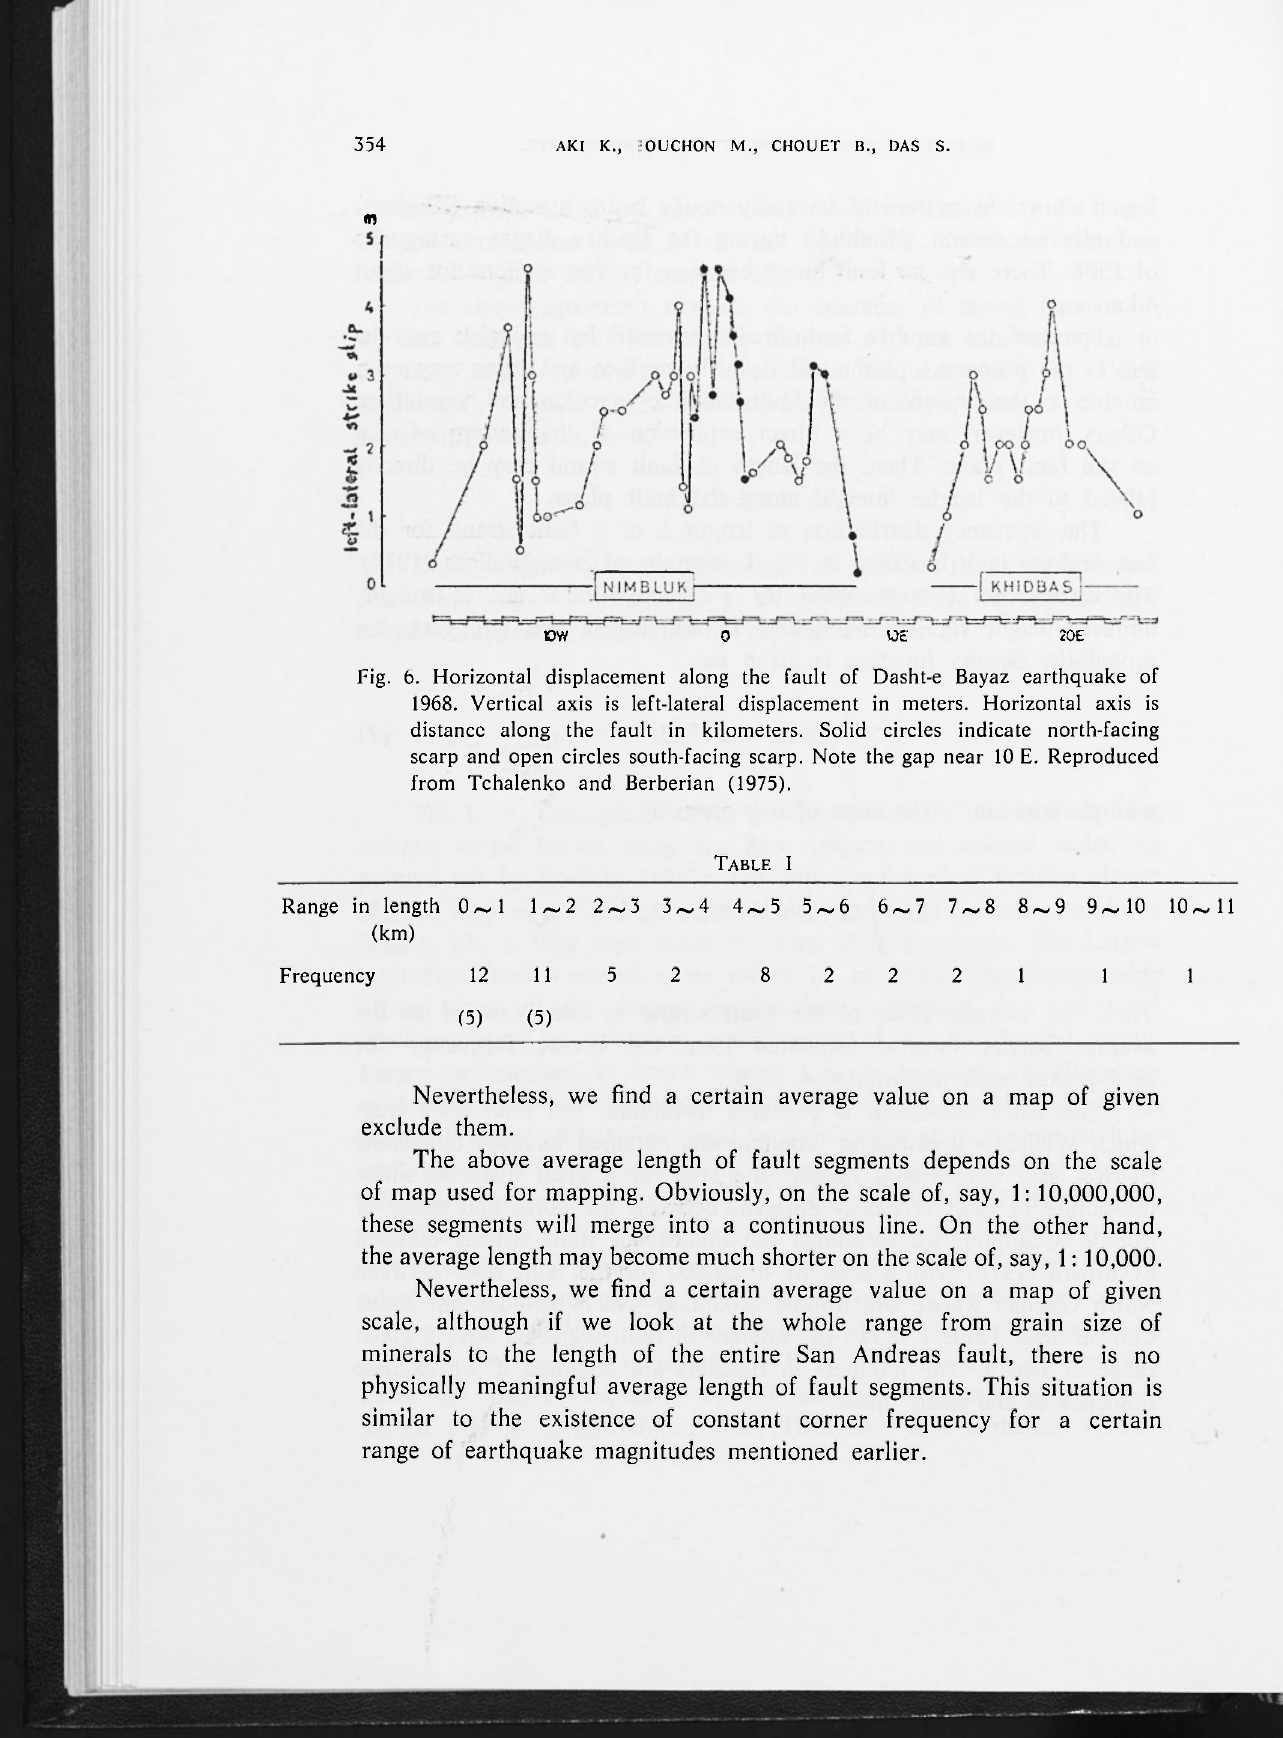
Fig. 6. Horizontal displacement along the fault of Dasht-e Bayaz earthquake of 1968. Vertical axis is left-lateral displacement in meters. Horizontal axis is distance along the fault in kilometers. Solid circles indicate north-facing scarp and open circles south-facing scarp. Note the gap near 10 E. Reproduced from Tchalenko and Berberian